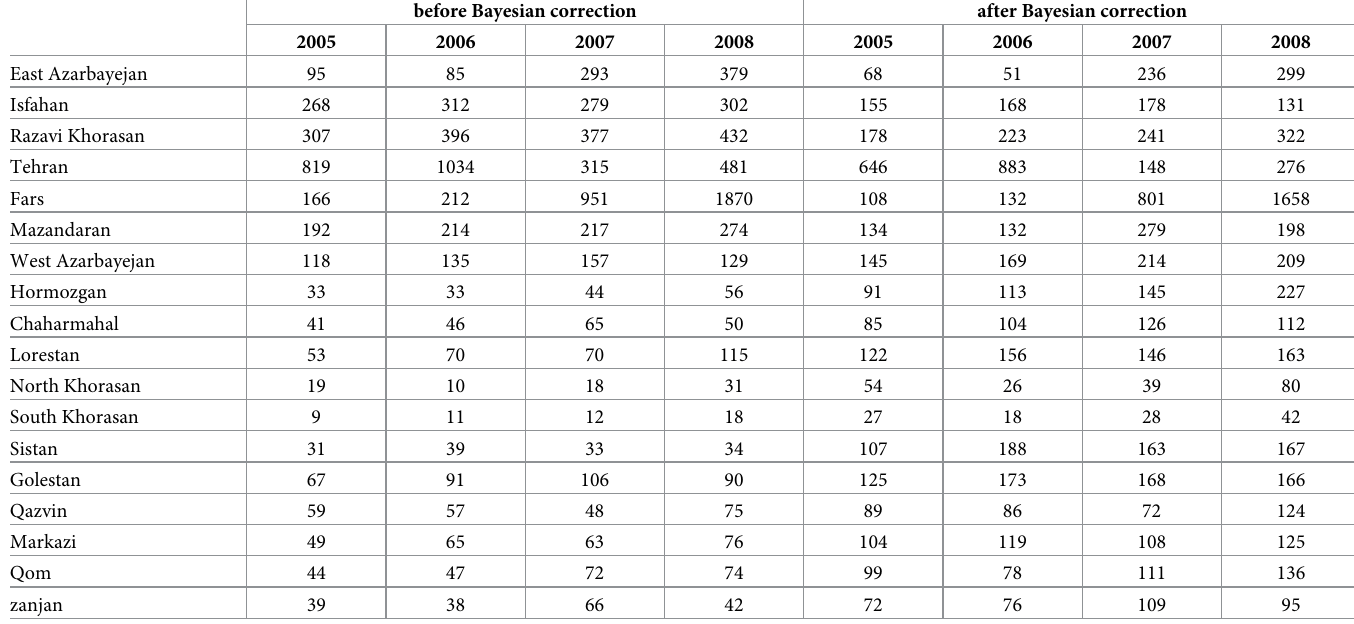
Table 4. Number of colorectal cancer incidence and the percent of change before and after Bayesian correction in Iranian provinces 2005–2008. before Bayesian